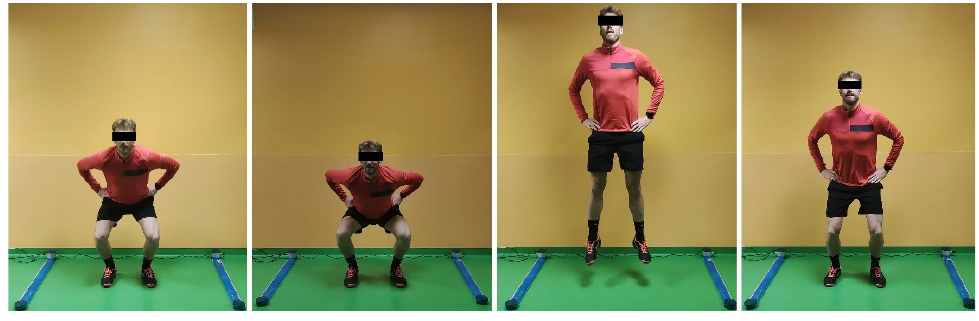
Figure 1. Bipodalic squat jump.